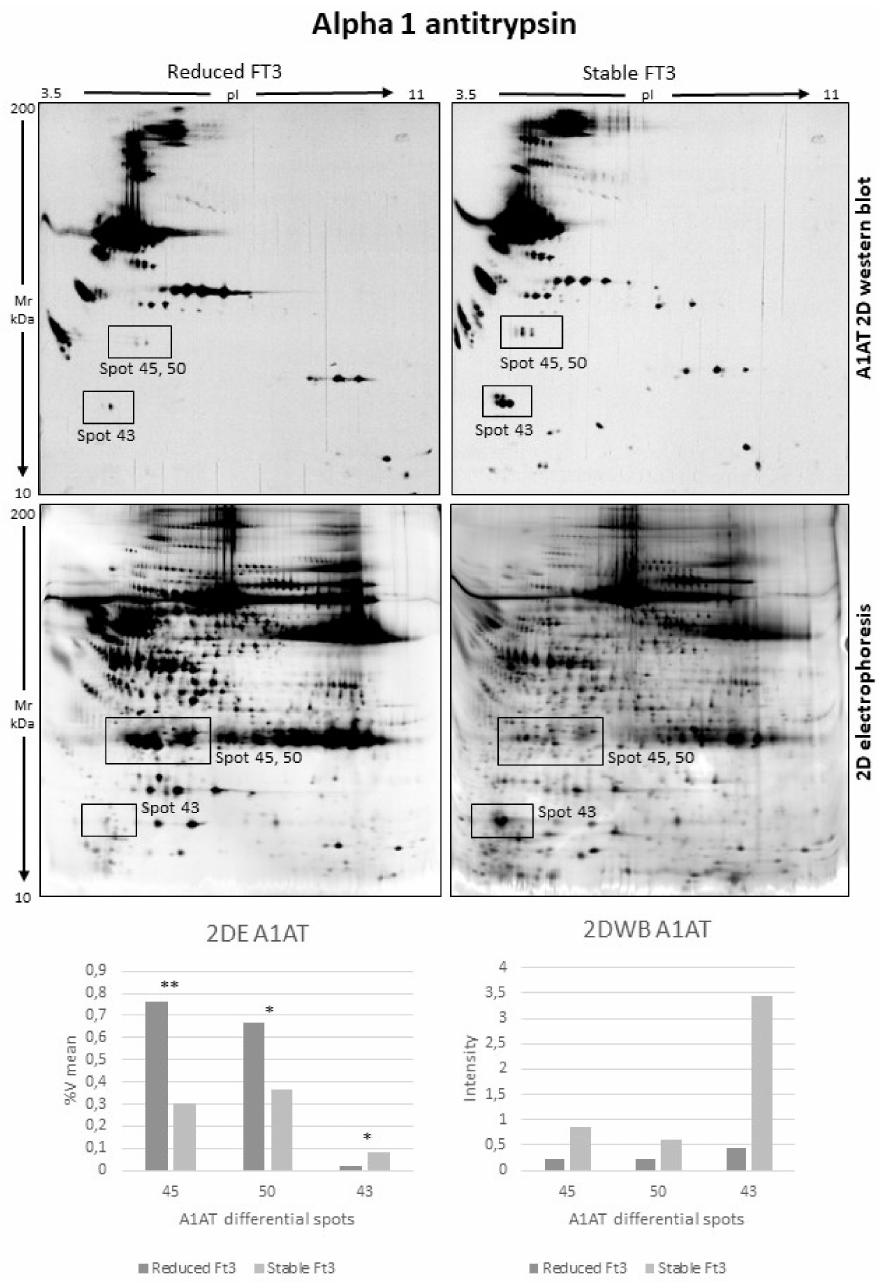
Figure 4. Two-dimensional western blot (2DWB) analysis of alpha 1 antitrypsin (A1AT) (* = p -value < 0.05; ** = p -value < 0.01) (2DWBs reported in figure are the entire WB membrane images). Squares on the images highlight the areas where spots 45, 50, and 43 are